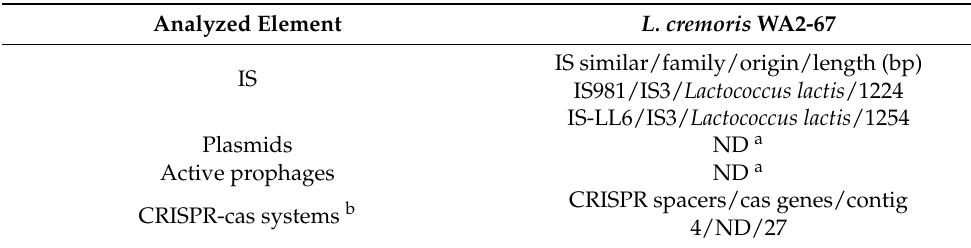
Table 1. MGE (IS, prophages and plasmids) and CRISPR-cas systems identified in the genome of L. cremoris WA2-67, characterized in this